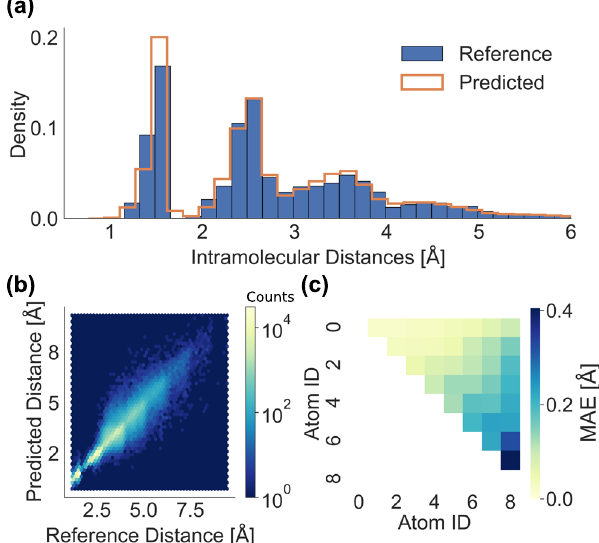
Fig. 7 Analysis of G2S distance predictions of C 7 NOH 11 constitutional isomers. For all predictions, G2S was used with the bond length representation and a maximal training set size (4687). a Histograms of B3LYP reference (blue) and G2S predicted distances (orange). b Hexbin heatmap visualization of B3LYP reference and predicted distances. c Heatmap of MAE for each entry of predicted distance